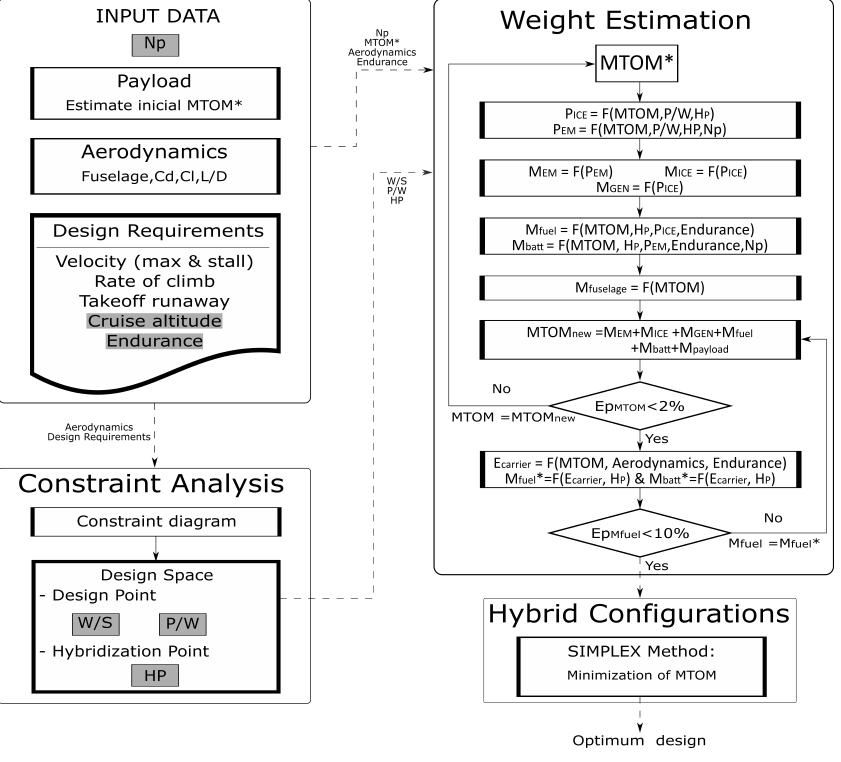
Figure 3. Proposed Methodology.